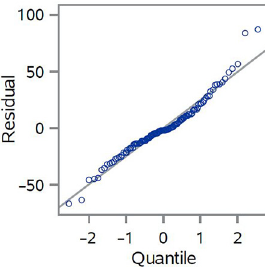
Figure 10. AFGSC Cann regression fi t plot